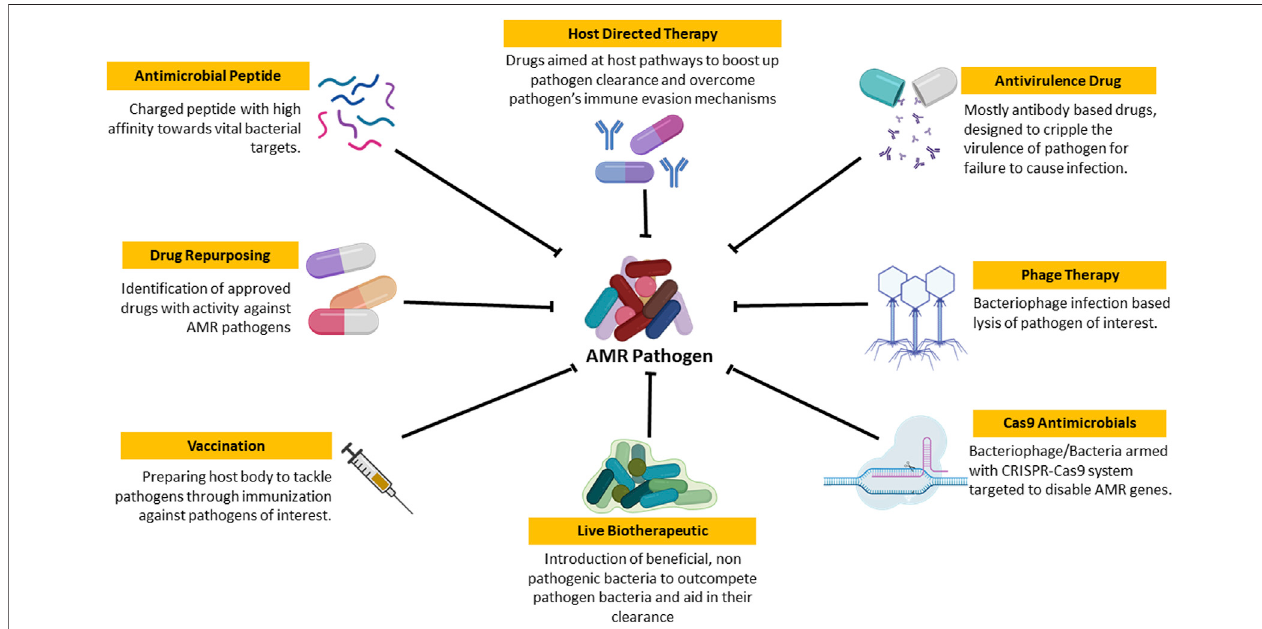
FIGURE3| SchematicrepresentationofnewerapproachestotackleAMRPathogen:Thesearethesetofapproachesthatarecurrentlyunderresearchforef fi cient treatment of AMR pathogen based infection and its spread.